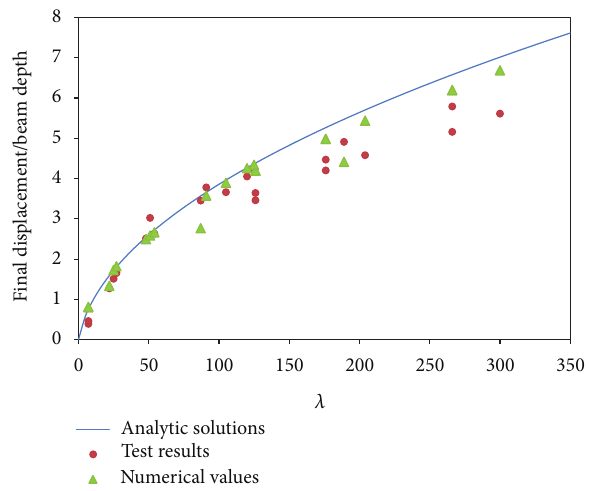
Figure 7: A comparison of different analysis methods for the alu- minum beam.